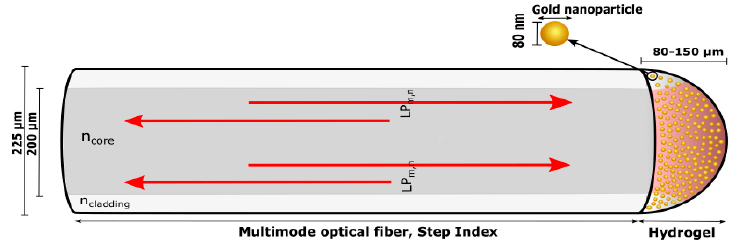
Figure 14. Illustration of the multimode optical fiber with hydrogel containing gold nanoparticles immobilized on a fiber end. Visible light is guided in the fiber core with the numerical aperture colored with red in the hydrogel. Reprinted with permission from Ref. [89].